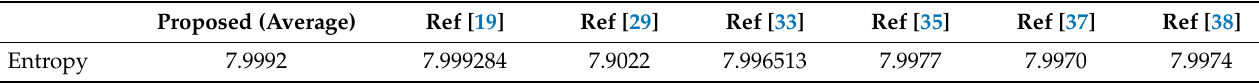
Table 5. Information entropy